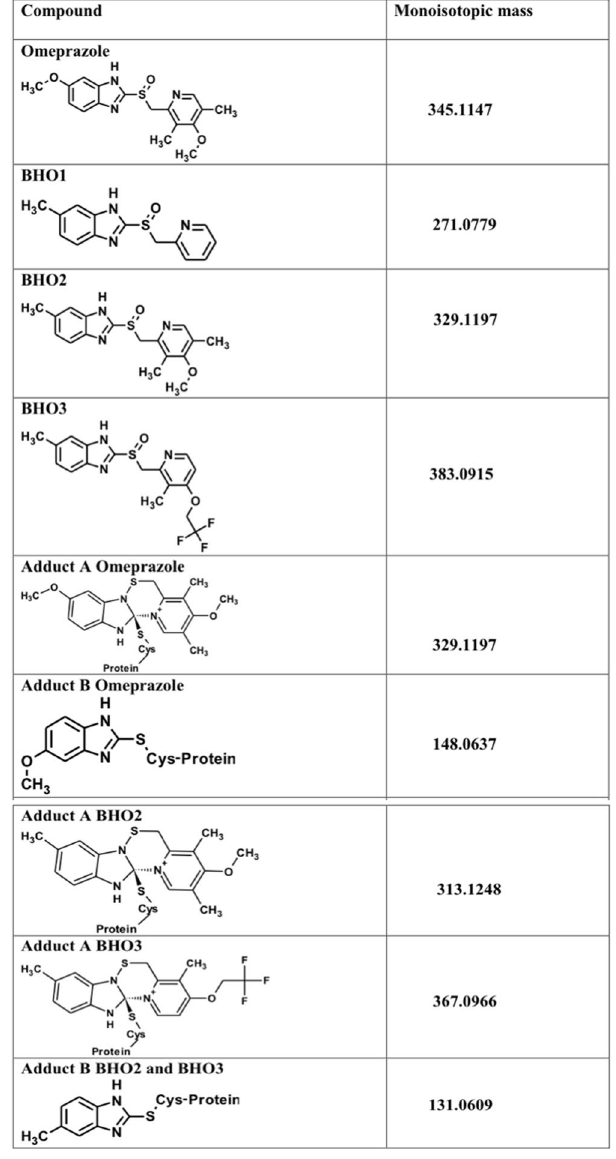
Figure 1. Structure and monoisotopic mass values of compounds and their adducts. The structures and masses were obtained by using ChemSketch softwarse